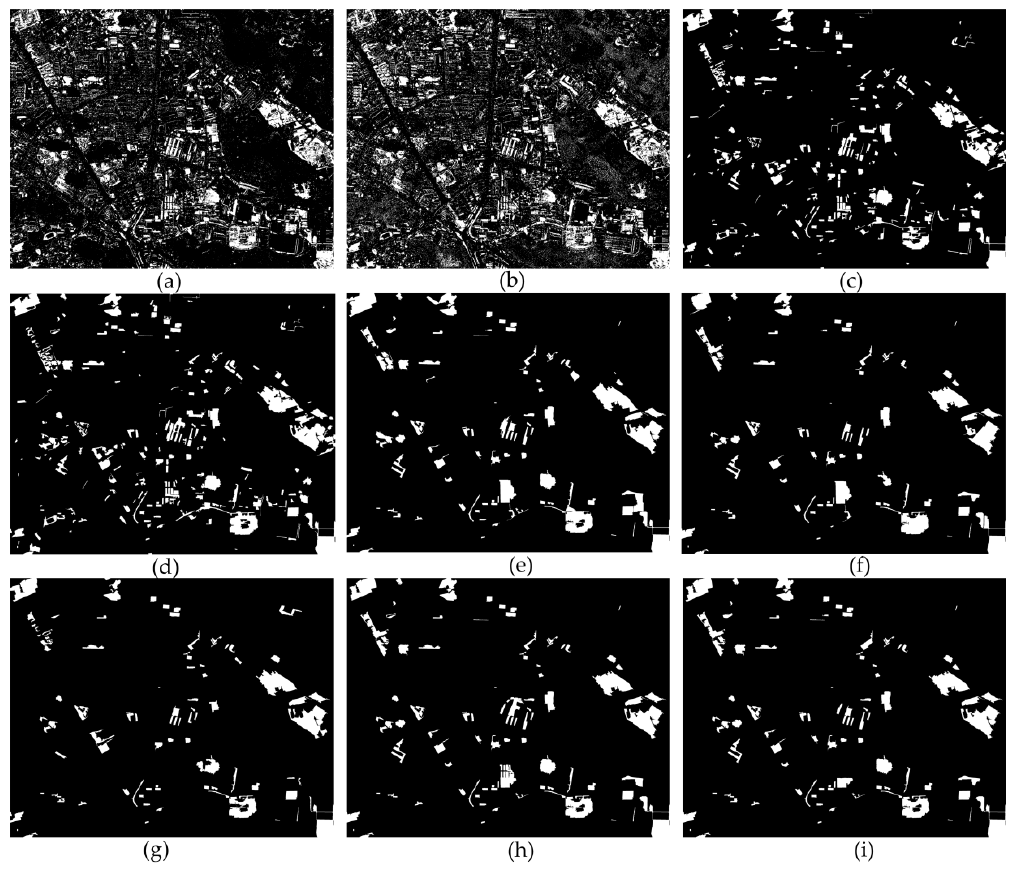
Figure 15. Comparison of different methods for DS1. ( a ) NCIA; ( b ) PCA- k -means; ( c ) OCVA; ( d ) RoF-scale 102; ( e ) RoF-scale 179; ( f ) RoF-scale 213; ( g ) ELM-MV; ( h ) RF-MV; ( i ) RoF-MV. Table 2. Performance comparison of different approaches for DS1.